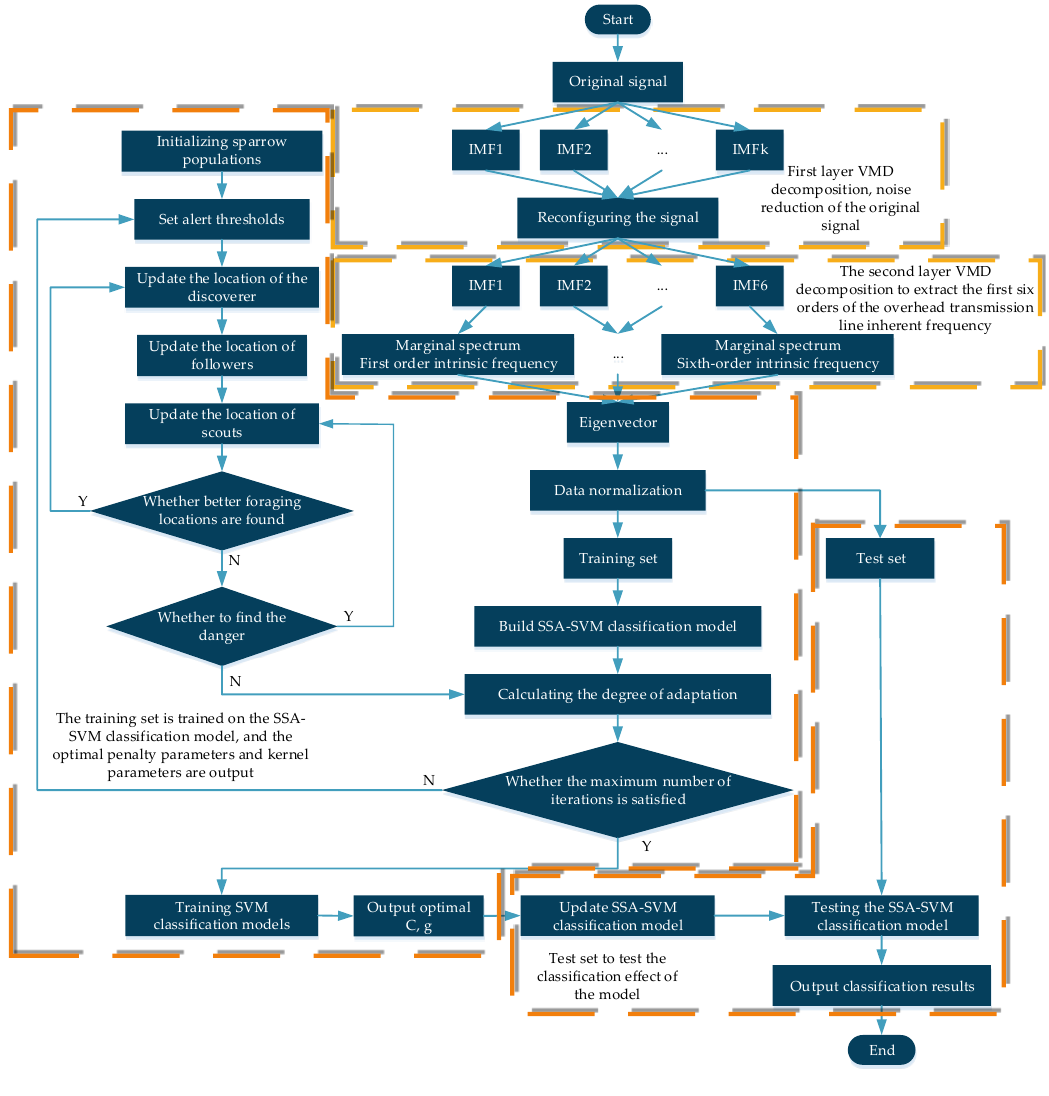
Figure 1. Basic flow of VMD-SSA-SVM identification model.